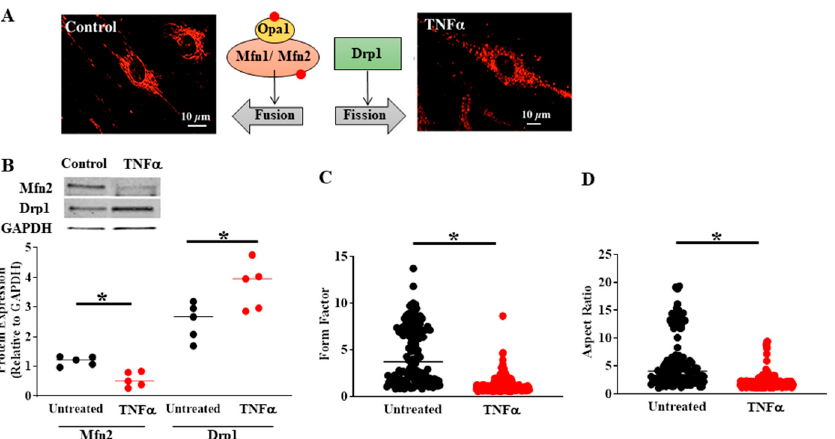
Figure 4. Compared to untreated controls, TNF α (20 ng/mL, 24 h) exposure induced mitochondrial fragmentation in human ASM ( A ) associated with reduced Mfn2 and increased Drp1 protein levels ( B ). The extent of mitochondrial fragmentation was assessed by calculating ( C ) form factor and ( D ) aspect ratio of mitochondria labeled using MitoTracker Red ( A ). In B, cells were dissociated from ASM samples from n = 5 patients and divided into TNF α treated and untreated control groups. In C and D, multiple mitochondria/cells were measured from ASM cells isolated from n = 5 patients divided into TNF α treated and untreated control groups. (* denotes a significant difference between TNF α treated and untreated control groups; p < 0.05; t -test). All data are presented as scatter plots with lines indicating mean values. These figures are modified from presentations of previously reported results [4].